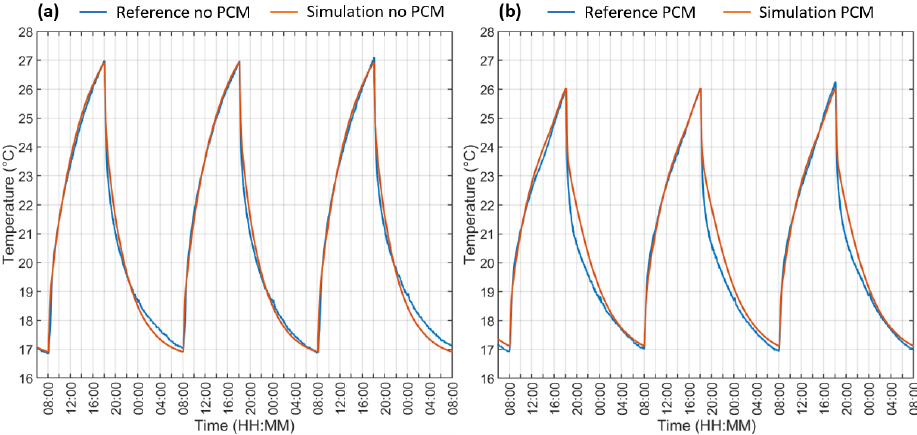
Figure 3. Comparison of average air temperature between experiment and simulation. ( a ) Without PCM, ( b ) With PCM.